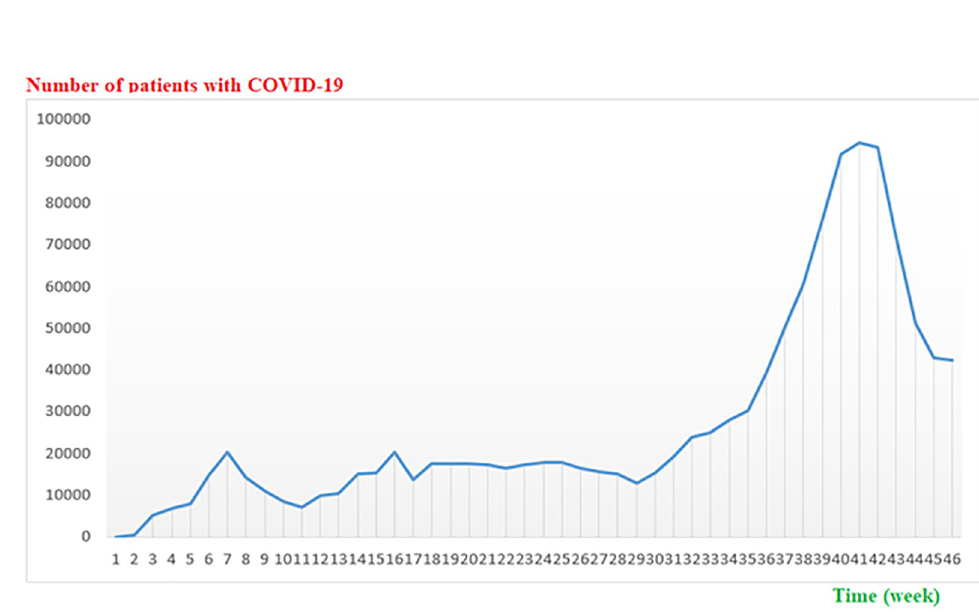
Fig 2. Weekly new cases of COVID-19 (16 Feb 2020 to 2 Jan 2021) in Iran.